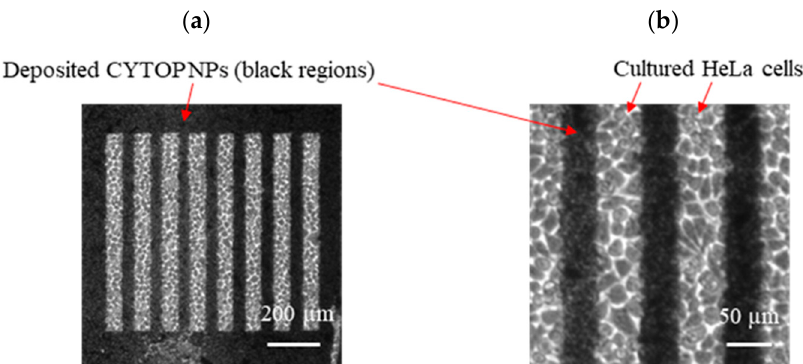
Figure 9. Microscope images showing ( a ) HeLa cells selectively cultured on the fabricated glass and ( b ) an enlarged view of the deposited NP-glass boundaries.